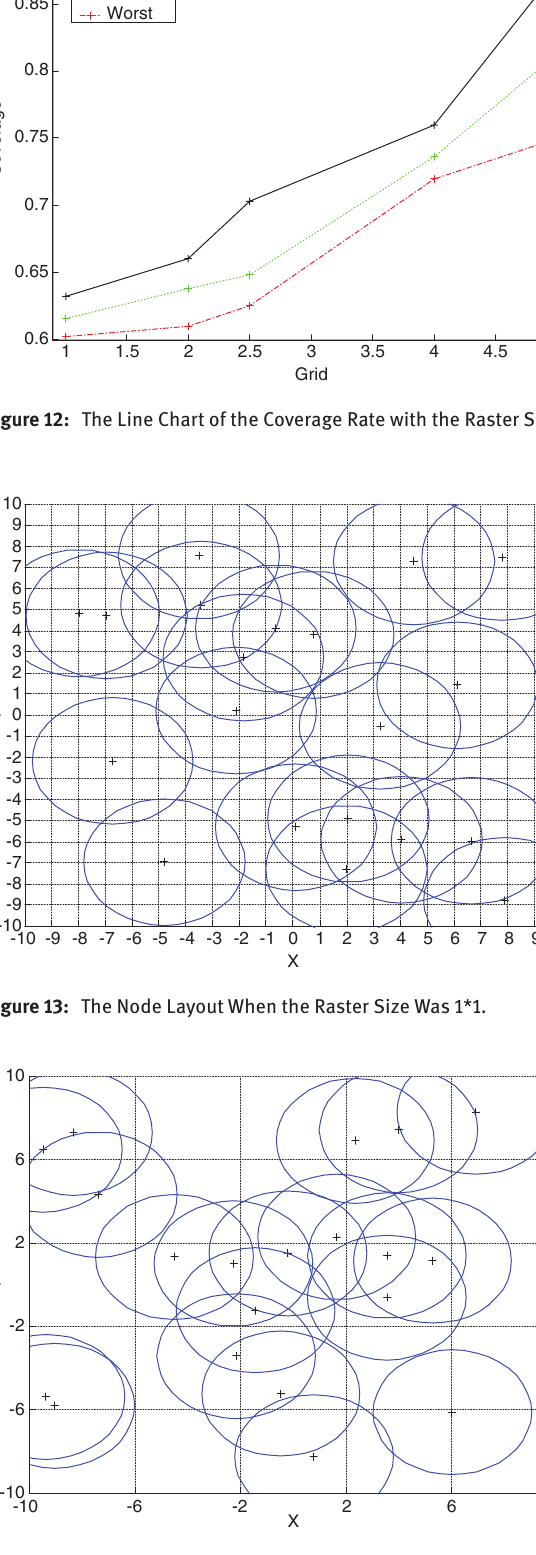
Figure 14: The Node Layout When the Raster Size Was